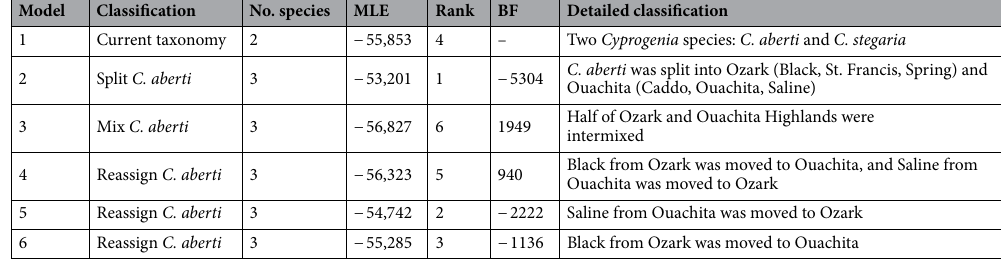
Table 4. Path sampling results for the six species delimitation models for Cyprogenia species shown in Fig. 2. All Bayes factor (BF) calculations are made against the current taxonomy model (Model 1). Therefore, positive BF values indicate support for current taxonomy model, and negative BF values indicate support for alternative model. The BF scale is as follows: 0 < BF < 2 is not worth more than a bare mention, 2 < BF < 6 is positive evidence, 6 < BF < 10 is strong support, and BF > 10 is decisive. Current and alternative species delimitation models were analyzed with the path sampling steps of 36, MCMC sample length of 100,000 for each path sampling step, alpha of 0.3, burnInPercentage = 10, and preBurnin of 10,000.